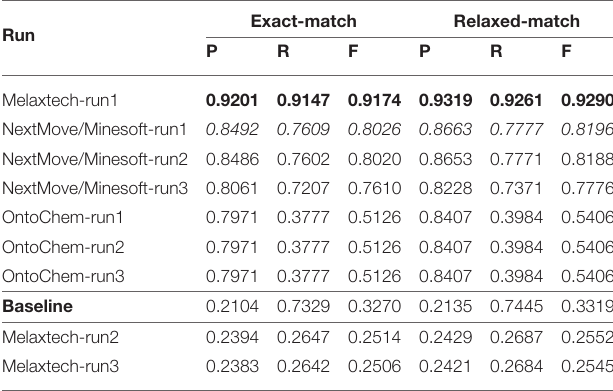
TABLE 9 | Overall performance of all runs in end-to-end systems.